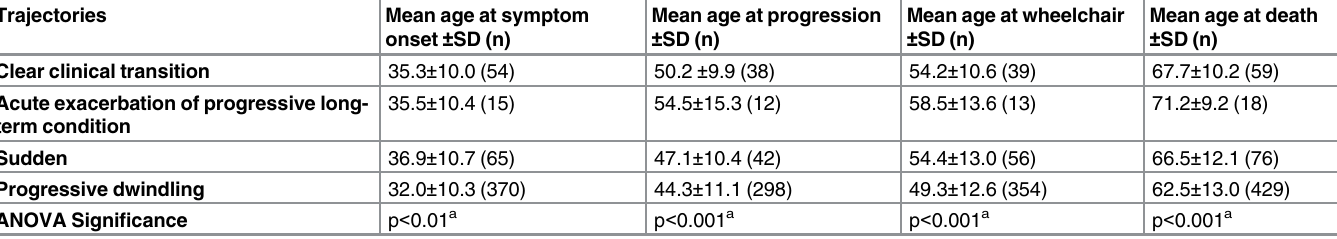
Table 2. Different Trajectories association with MS